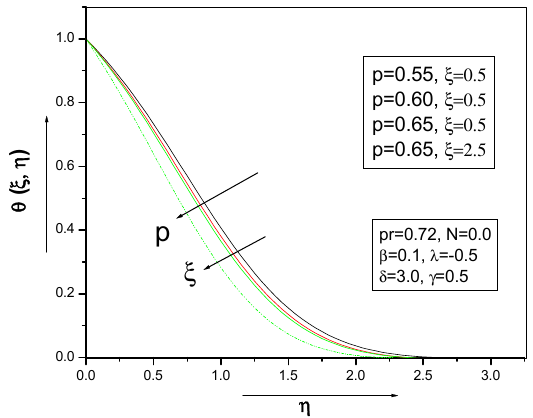
Figure 10. Effect of the velocity exponent parameter on temperature profile.